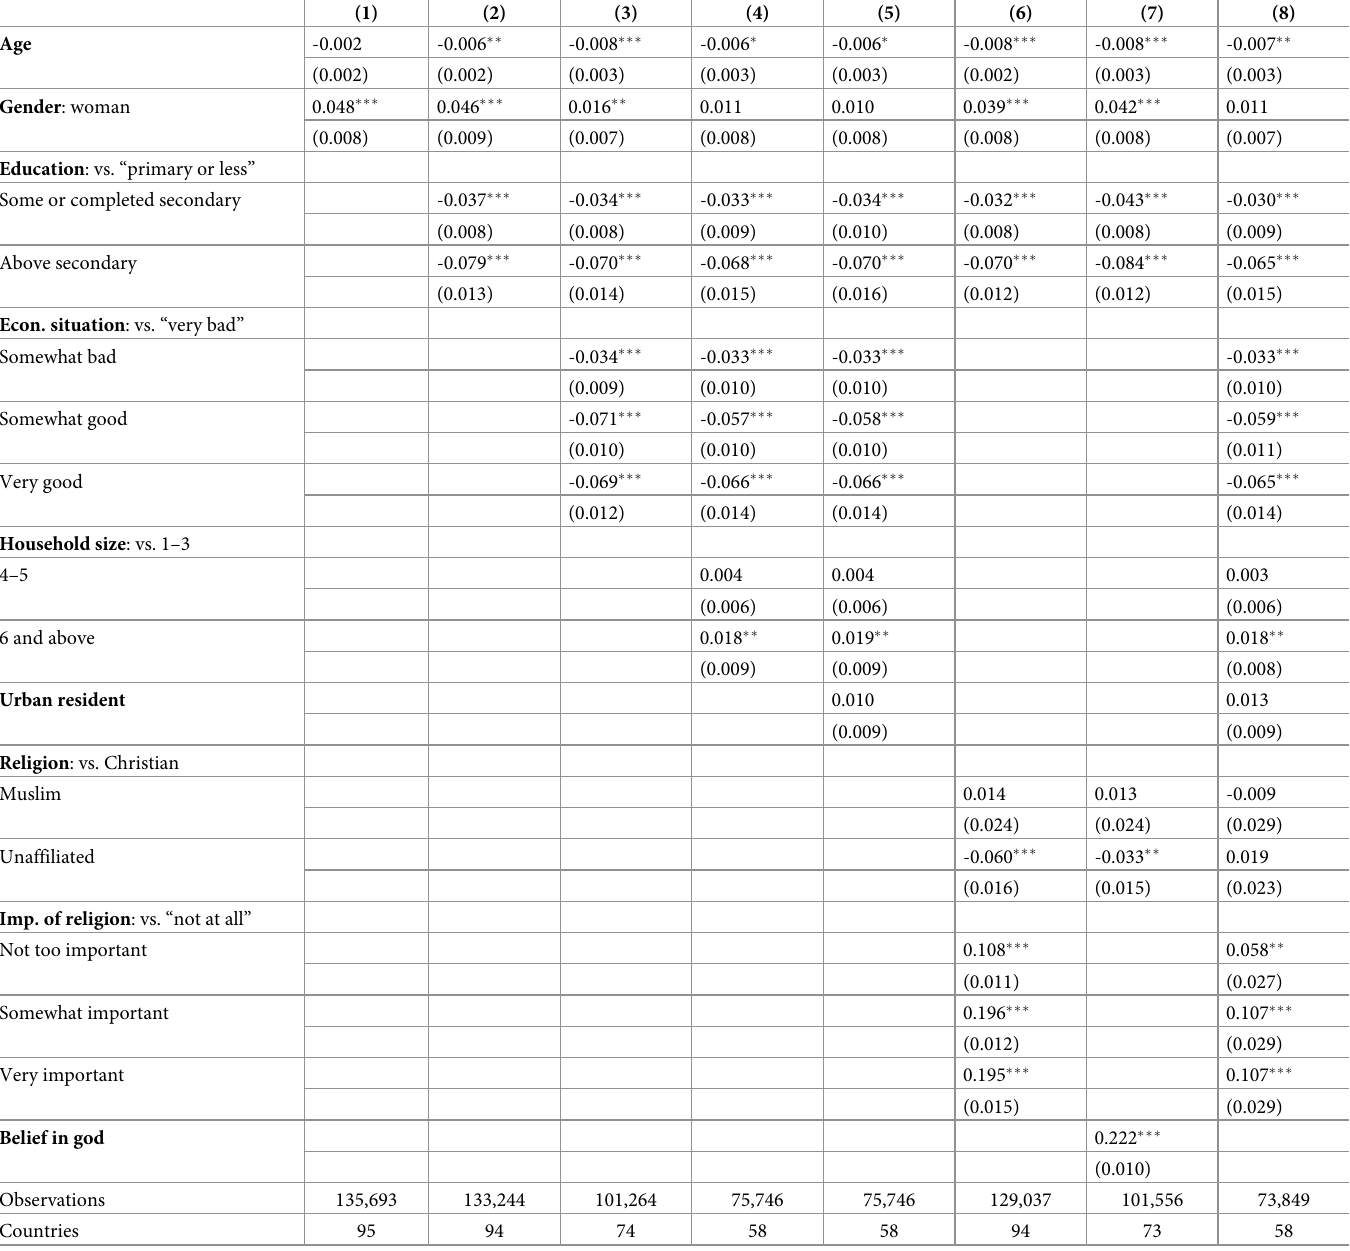
Table 1. Socio-demographic correlates of witchcraft beliefs: Regression